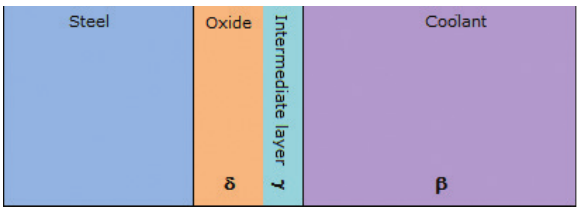
Figure 1. Layers near the